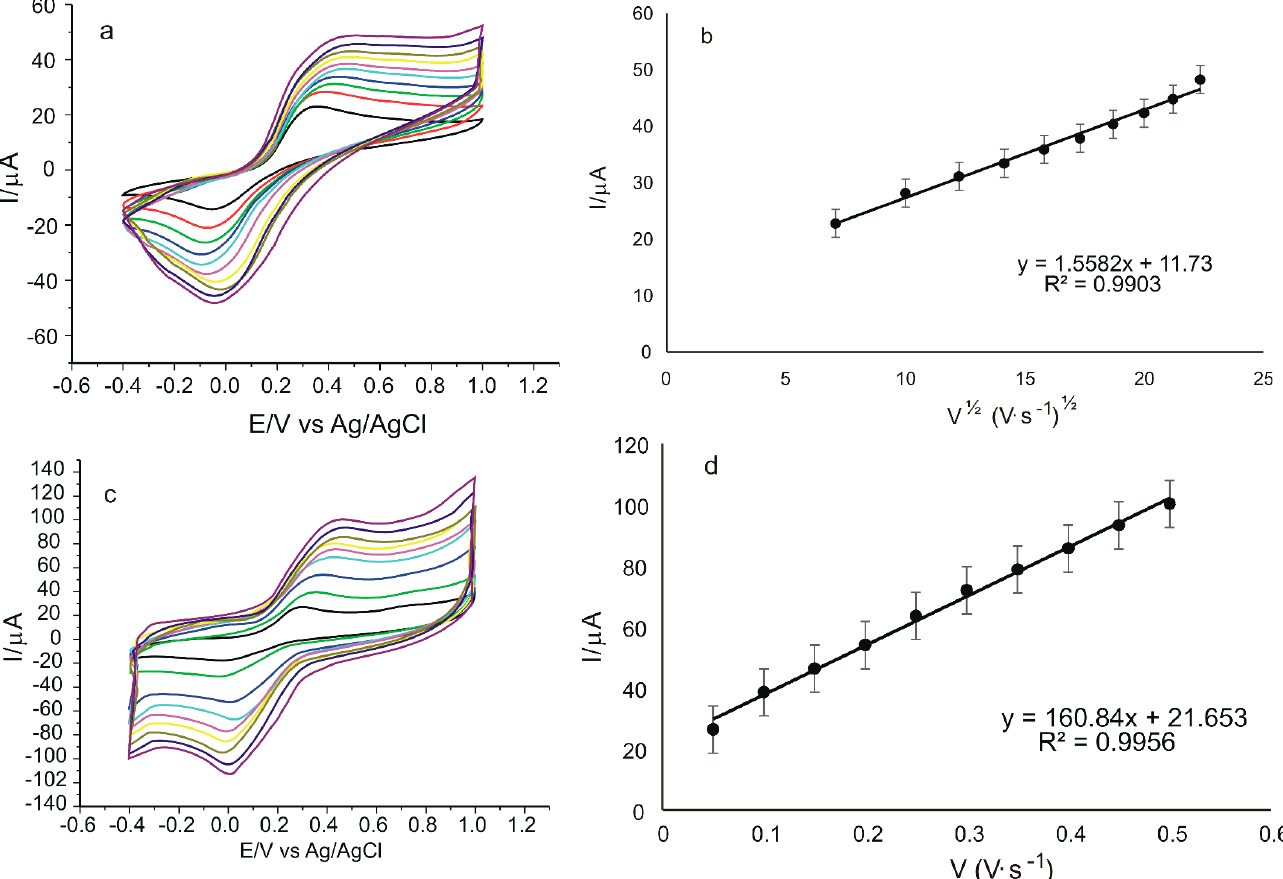
Figure 12. Cyclic voltammograms of GO/SPCE ( a ) and GO-Peptide/SPCE ( c ) immersed in 10 − 3 M rosmarinic acid–0.1 M PBS at pH = 6.5 recorded at scan rates between 0.05 and 0.5 V·s − 1 . Linear dependence between Ipa and square root of scan rate in the case of GO/SPCE ( b ) and linear dependence between Ipa and scan rate in the case of GO-Peptide/SPCE ( d ).